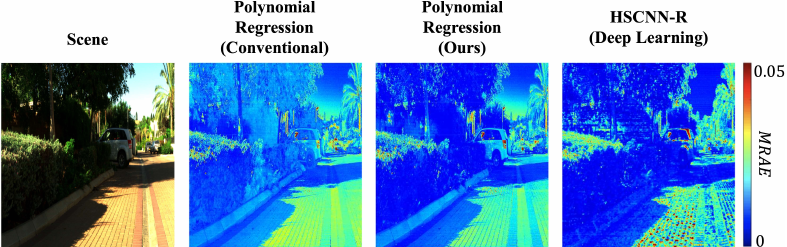
Figure 2. Example hyperspectral image reconstruction error heat maps (in MRAE) by the conven- tional Polynomial Regression [53] ( left ), Polynomial Regression based on our new RELS method ( middle ), and the deep learning-based HSCNN-R [60] ( right